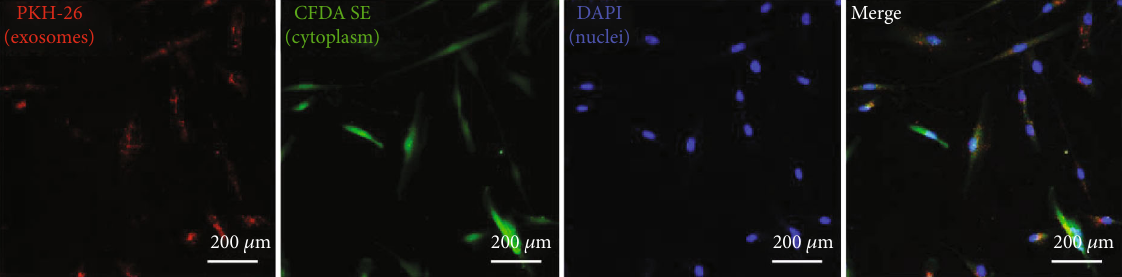
Figure 3: Internalization of exosomes by rBMSCs. PKH-26-labeled exosomes (red) were accumulated in the cytoplasm of rBMSCs after 6h coincubation. The nuclei of rBMSCs were stained with DAPI (blue). The cytoplasm of rBMSCs was stained with CFDA-SE (green). Scale bar: 200 μ